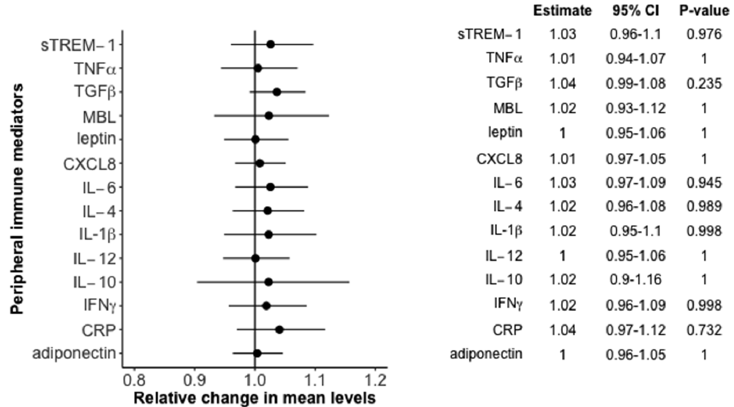
Figure 1. Relative change in mean levels of immune mediators with 95% confidence bands by 10 nmol/L increase in 25(OH)D levels in the birth cohort—results from the full adjusted model. IL, interleukin; IFN γ , interferon gamma; TNF α , tumor necrosis factor alpha; TGF β , transforming growth factor beta; CRP, c ‐ reactive protein; MBL, mannose ‐ binding lectin; sTREM ‐ 1, soluble triggering receptor expressed on myeloid cells ‐ 1; CXCL, chemokine (c ‐ x ‐ c motif) ligand. 3.3. Association between Peripheral Immune Mediators and 25(OH)D in the Newly Diagnosed Cohort We only found a statistical significant positive association between 25(OH)D (10 nmol/L increase) and CXCL8 (RC (95% CI), 1.07 (1.01; 1.13), p adjusted = 0.02), and a negative association between 25(OH)D (10 nmol/L increase) and leptin (RC (95% CI), 0.98 (0.96; 1.00), p adjusted = 0.01). The